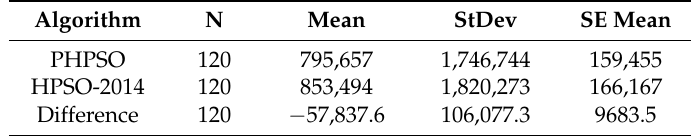
Table 8. Paired t -test for H 0 = PHPSO = HPSO vs. H 1 = PHPSO (cid:54) = HPSO on the best-known solutions. Algorithm N Mean